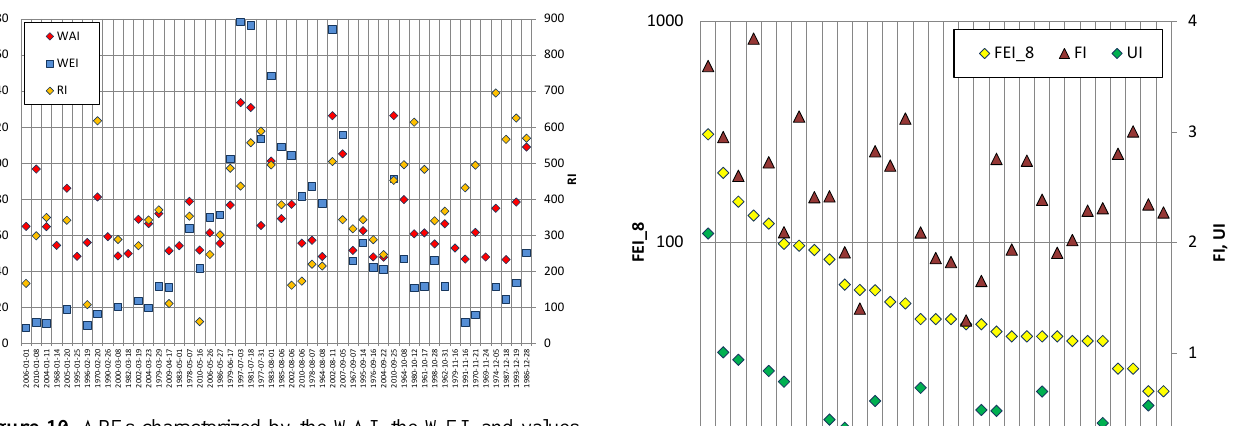
Figure 10. APEs characterized by the WAI, the WEI, and values of the index RI according to Ramos et al. (2014). The 50 APEs are ordered with respect to the calendar day in the increasing order.